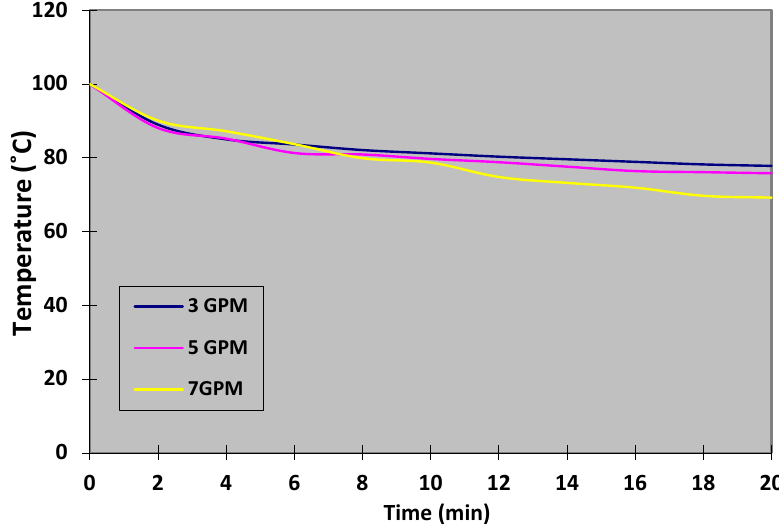
Figure 6. Surface temperature for the 100% distilled water.